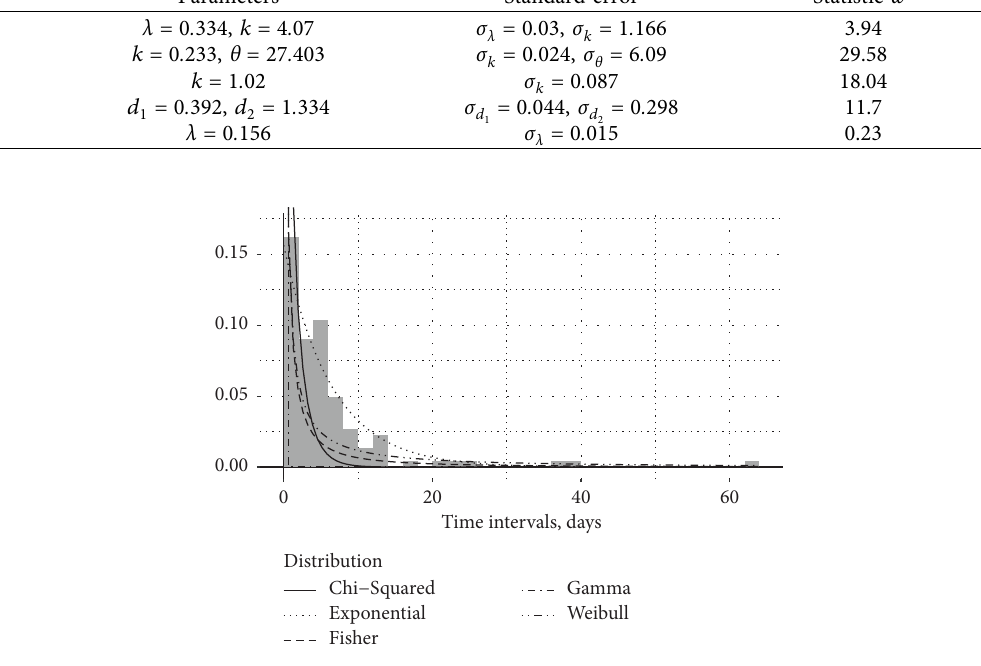
Figure 7: Probability distribution functions selected for time interval Table 4: Parameter estimates and standard error for distributions of loss data.